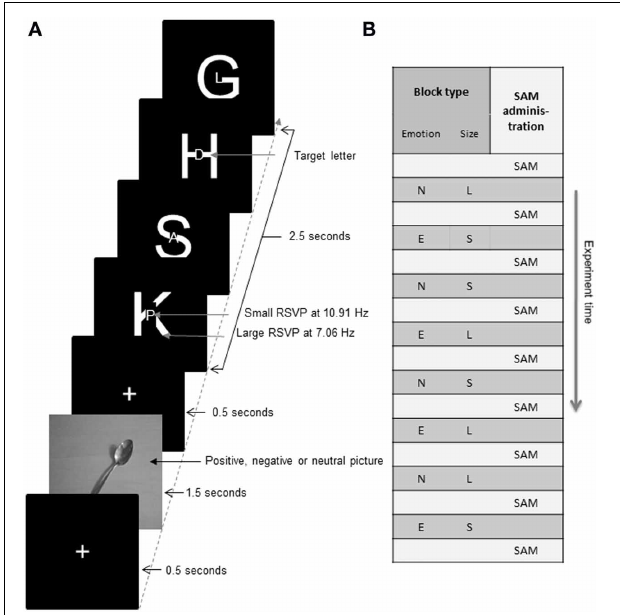
FIGURE 1 | (A) Schematic illustration of the experimental paradigm that depicts the arrangement of the RSVP stimuli in terms of the time layout of a single trial. The duration of each section of the trial is indicated alongside. The picture of the spoon is courtesy of the authors and serves for illustration only. (B) Schematic layout of a possible block order. N and E indicate blocks where either neutral pictures (N), or emotion pictures (E being positive or negative pictures based on which group the participant was assigned to) were shown before each trial. L and S stand for whether the instructions asked the participant to attend the large or small letter stream. SAM scores were taken once before the experiment began and then again after each